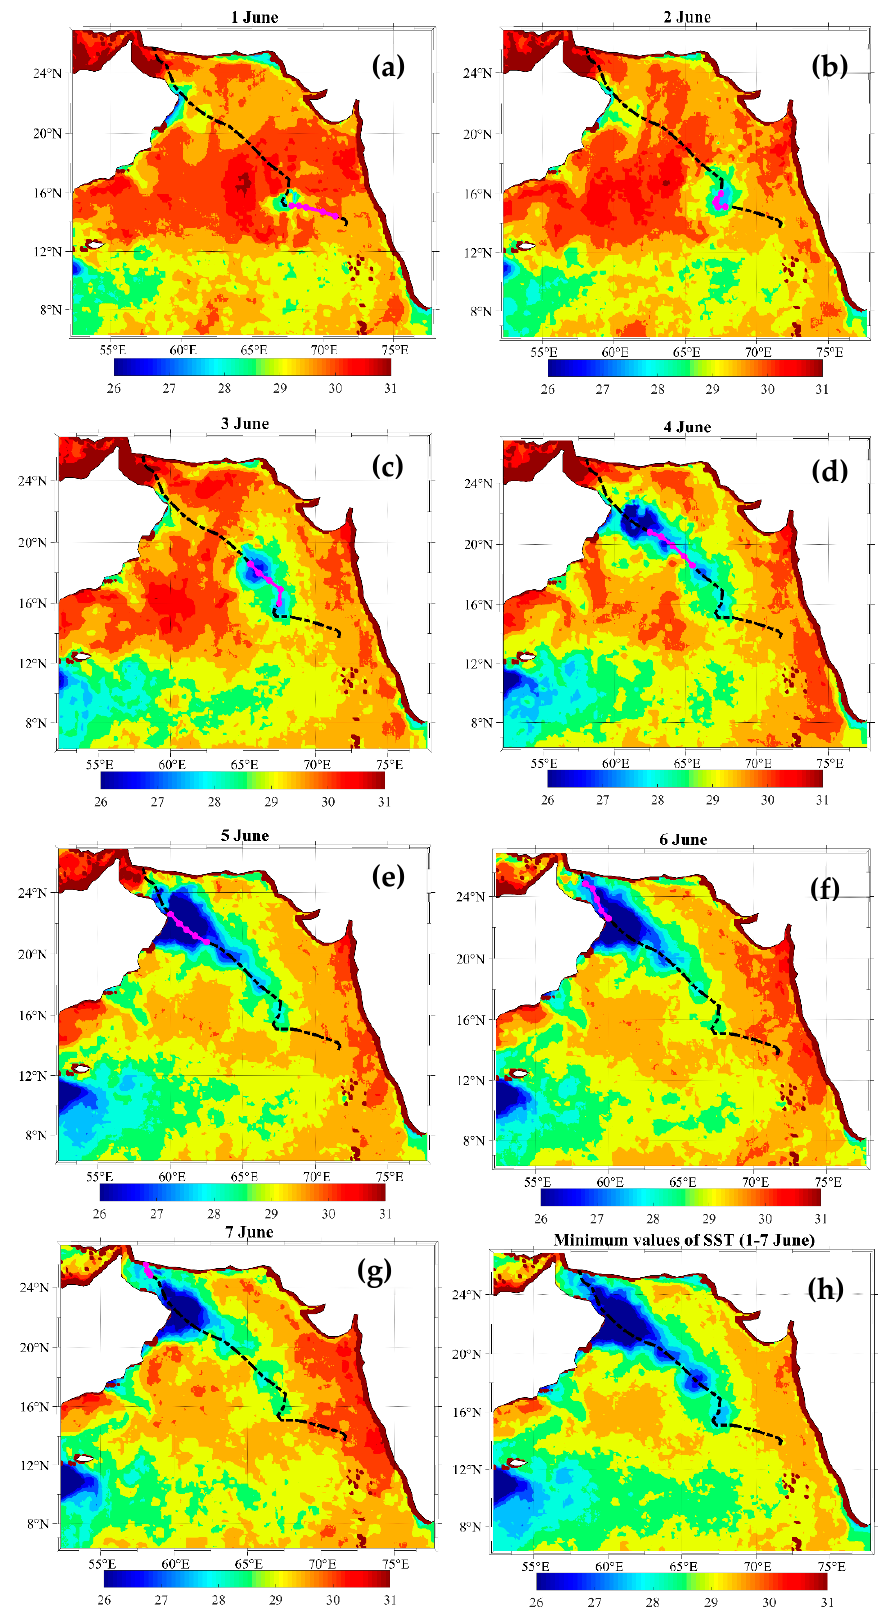
Figure 2. SST maps of Gonu based on OI_SST data: ( a – g ) daily and ( h ) minimum SST in the study area during 1–7 June